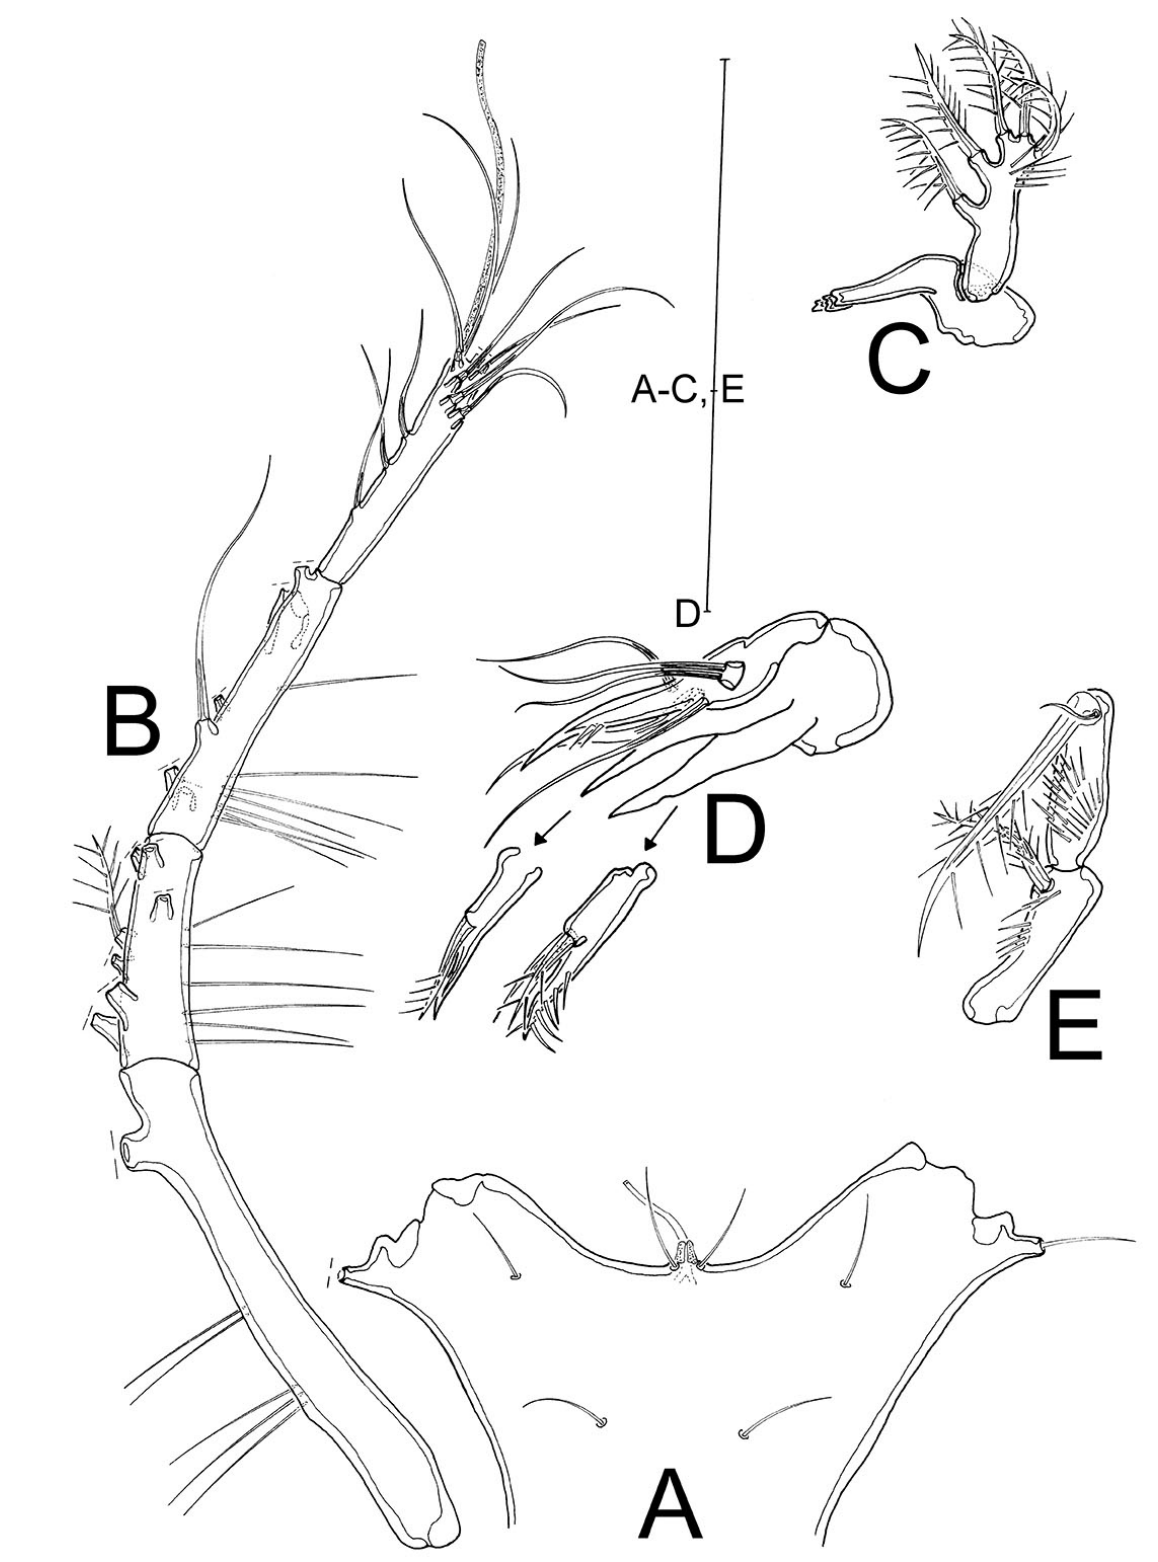
Fig. 4. Poropsyllus menzelae gen. et sp. nov., female holotype (HUJ INVCRUCOP808). A . Cephalothoracic peak. B . A1. C . Md. D . Mx. E . Mxp. Scales: 50